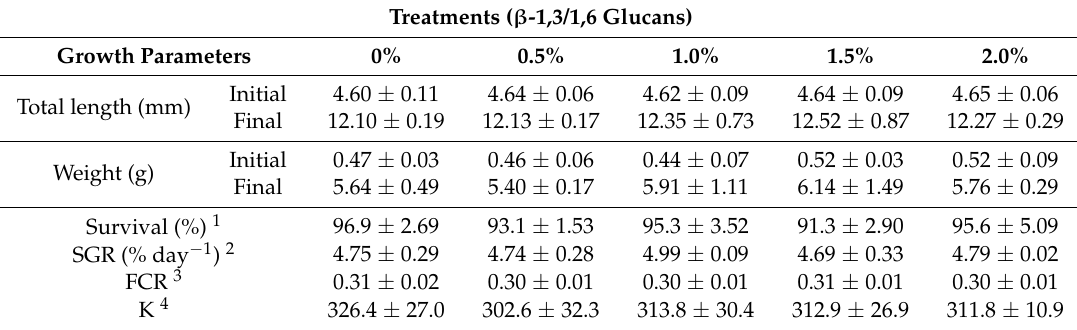
Table 1. Survival and growth parameters of A. tropicus fed formulated diets with different concentrations of β -1,3/1,6 glucans (0%, 0.5%, 1.0%, 1.5%, and 2.0%).